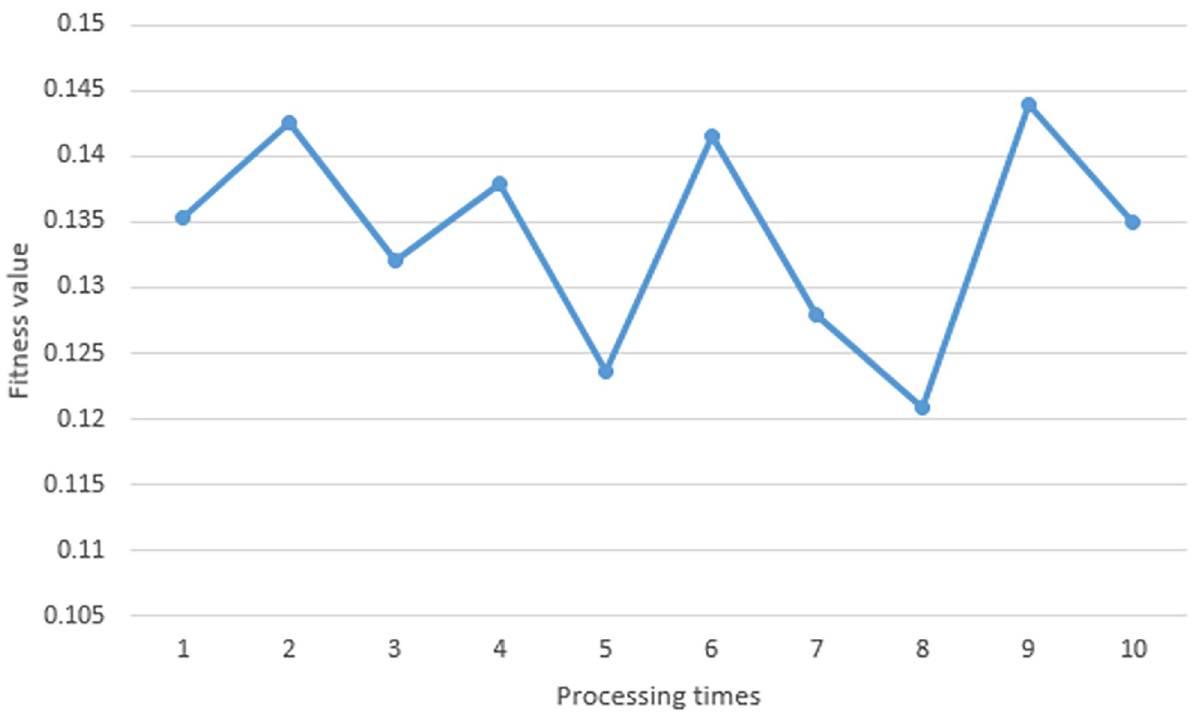
Fig 27. The fitness value obtained in a static environment (4